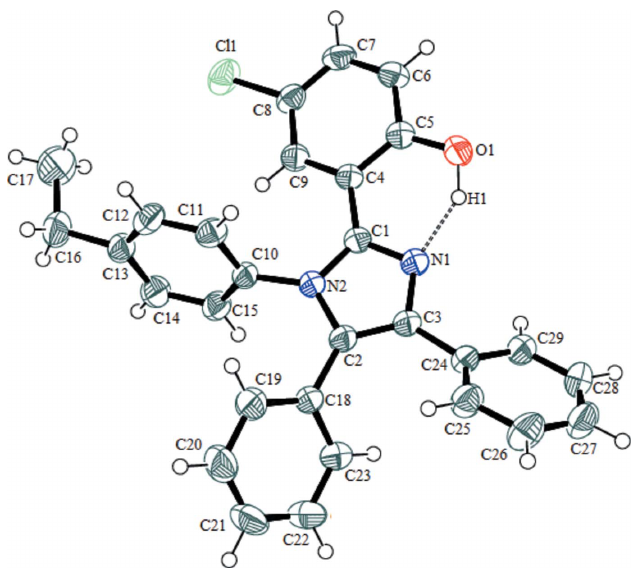
Figure 1 The molecular structure of the title compound with the atom-numbering scheme. Displacement ellipsoids are drawn at the 50% probability level. H atoms are represented as small spheres of arbitrary radius.